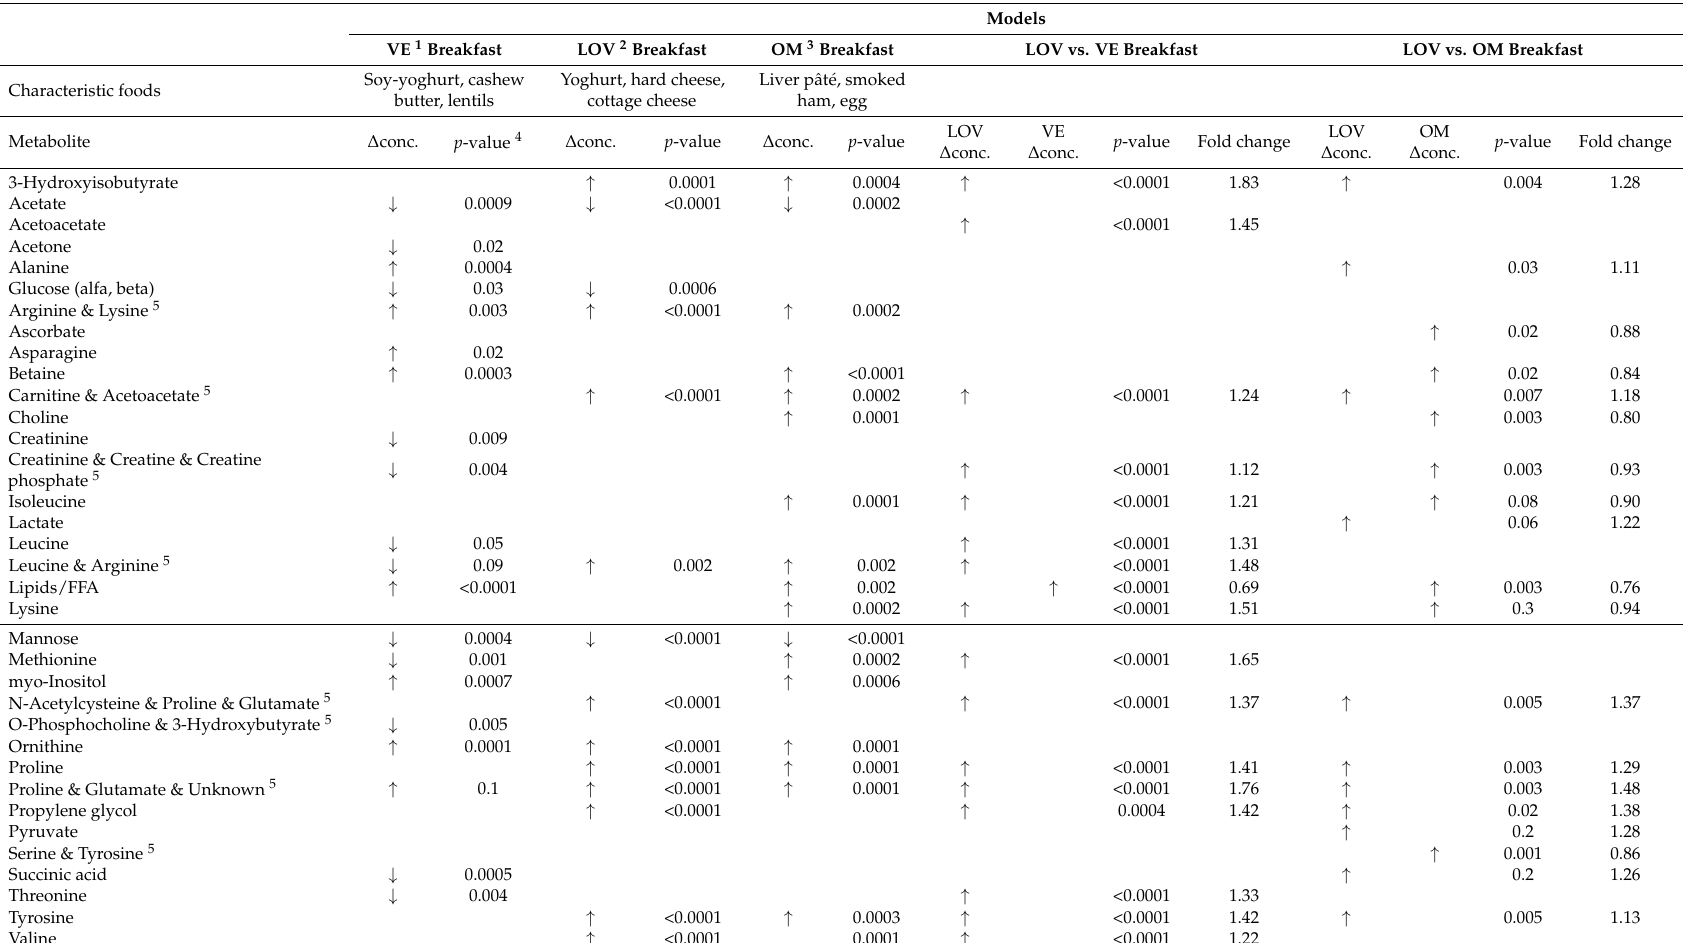
Table 3. Selected discriminating metabolites in OPLS-EP